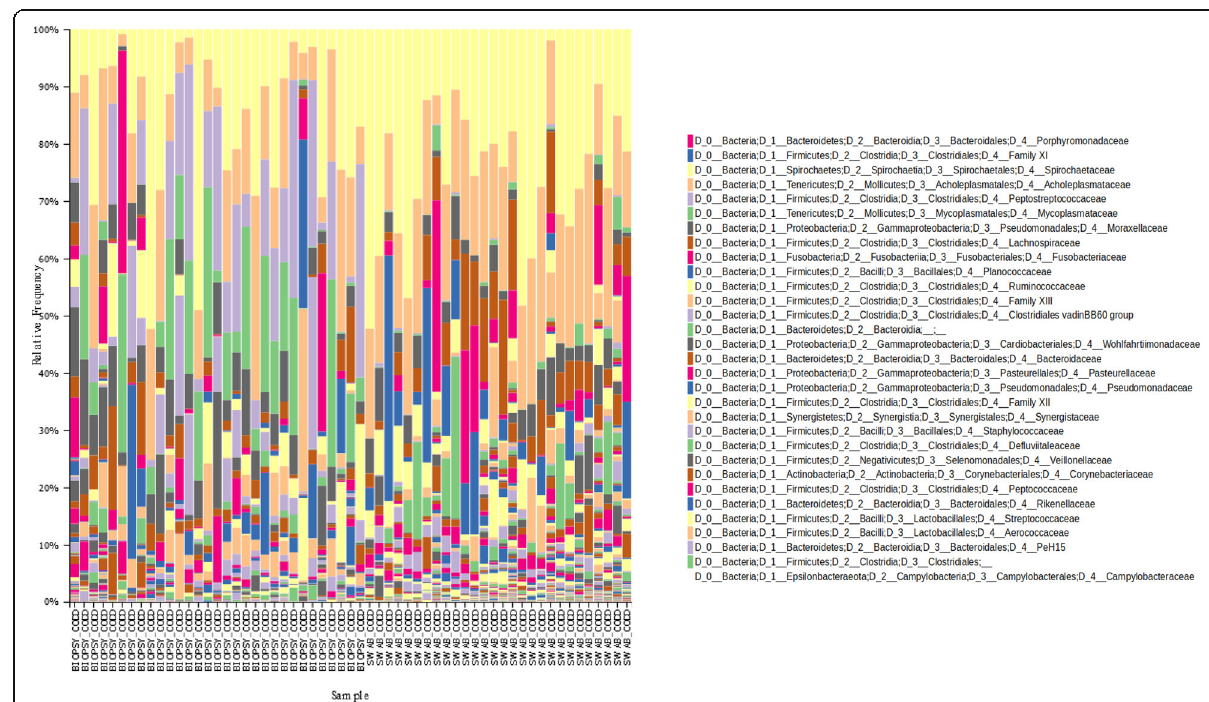
Fig. 14 A taxa bar plot showing relative abundance of bacterial families in the microbiome of the ovine foot affected by CODD in samples obtained by lesion biopsy compared with lesion